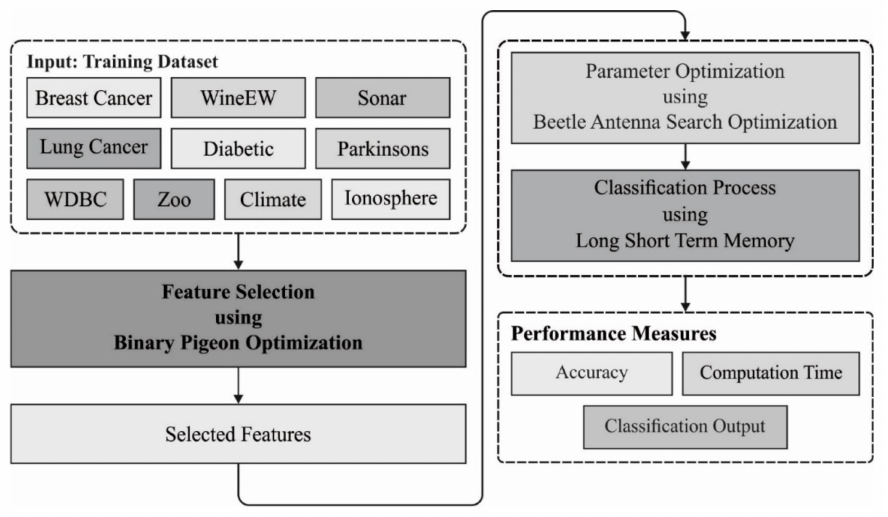
Figure 1. Overall process of the MOBDC-MR